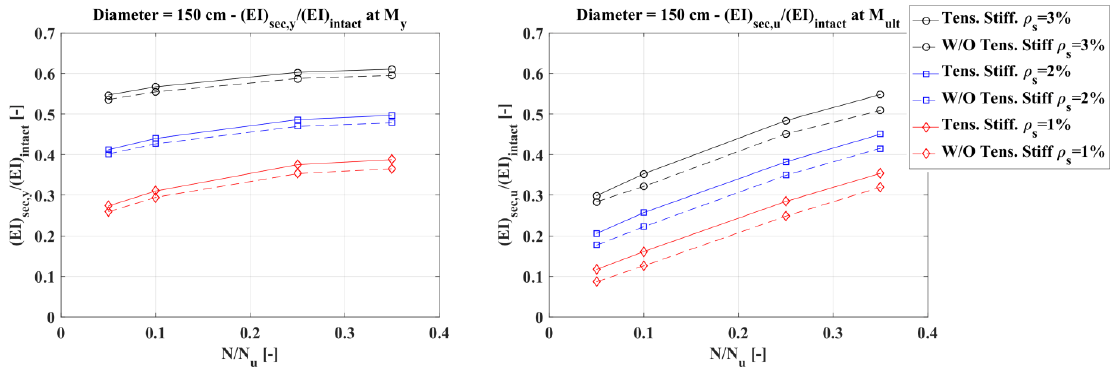
Figure 15. Diameter 150 cm: normalized secant stiffness at first steel bar yielding ( left ) and at peak stress in compression ( right ).